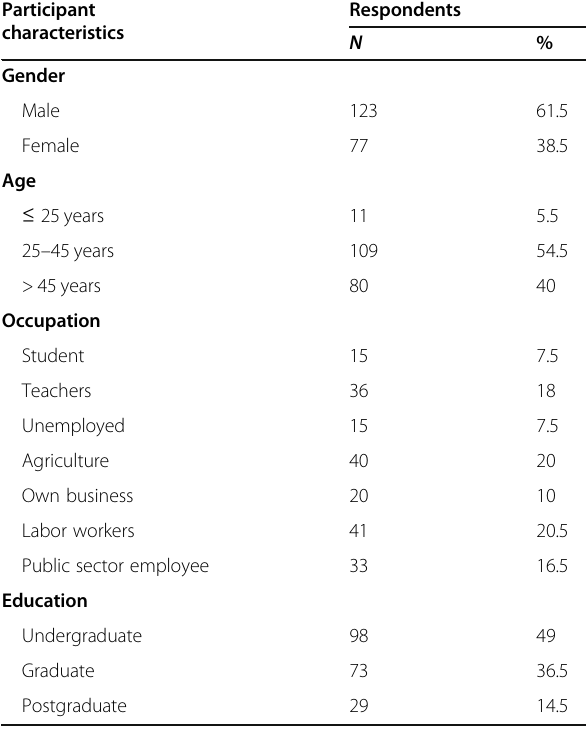
Table 1 Demographic characteristics of HCV-positive